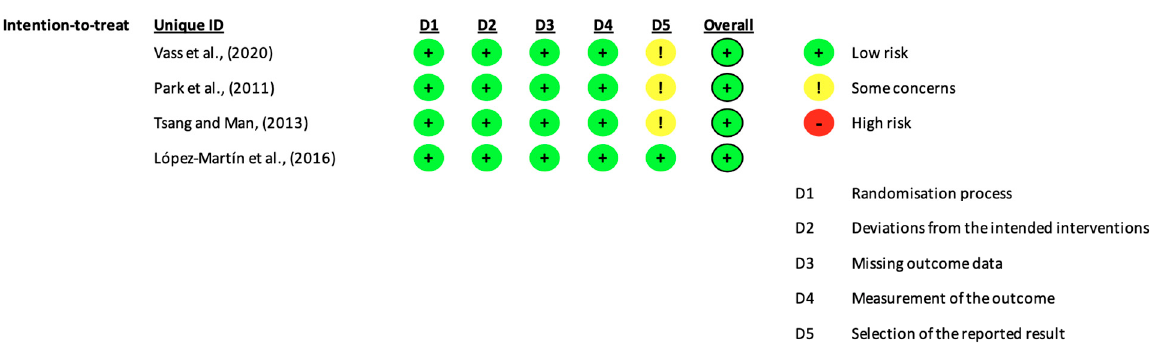
Figure 2. Risk of bias assessment for the included studies [19].